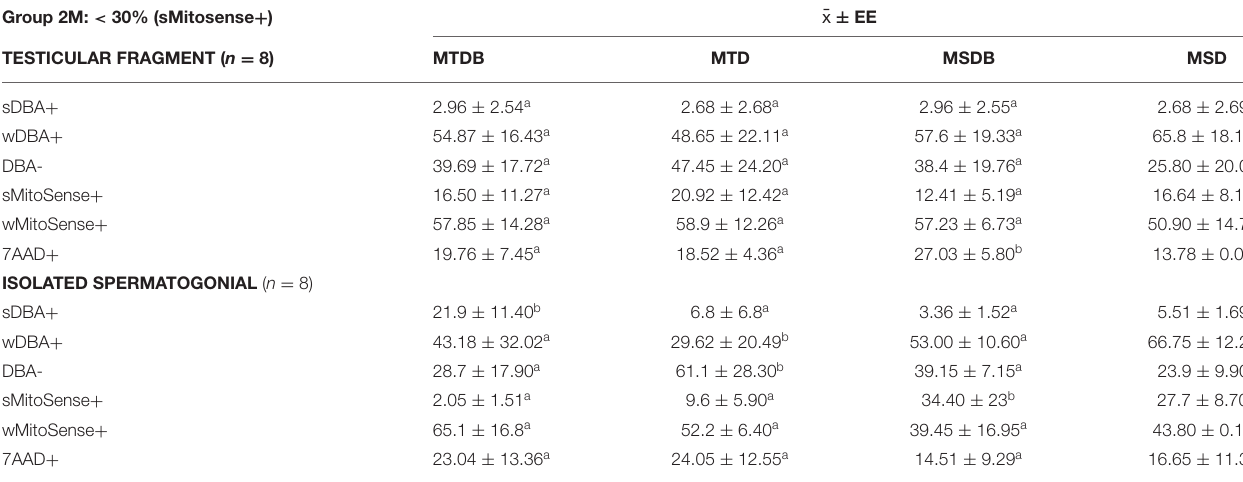
TABLE 4 | Mean percentage of spermatogonial stem cells with intact mitochondrial membranes (sMitoSense + ), undergoing, early apoptosis (wMitoSense + ) and necrosis (7AAD + ) in group 2M. Group 2M: < 30% (sMitosense +